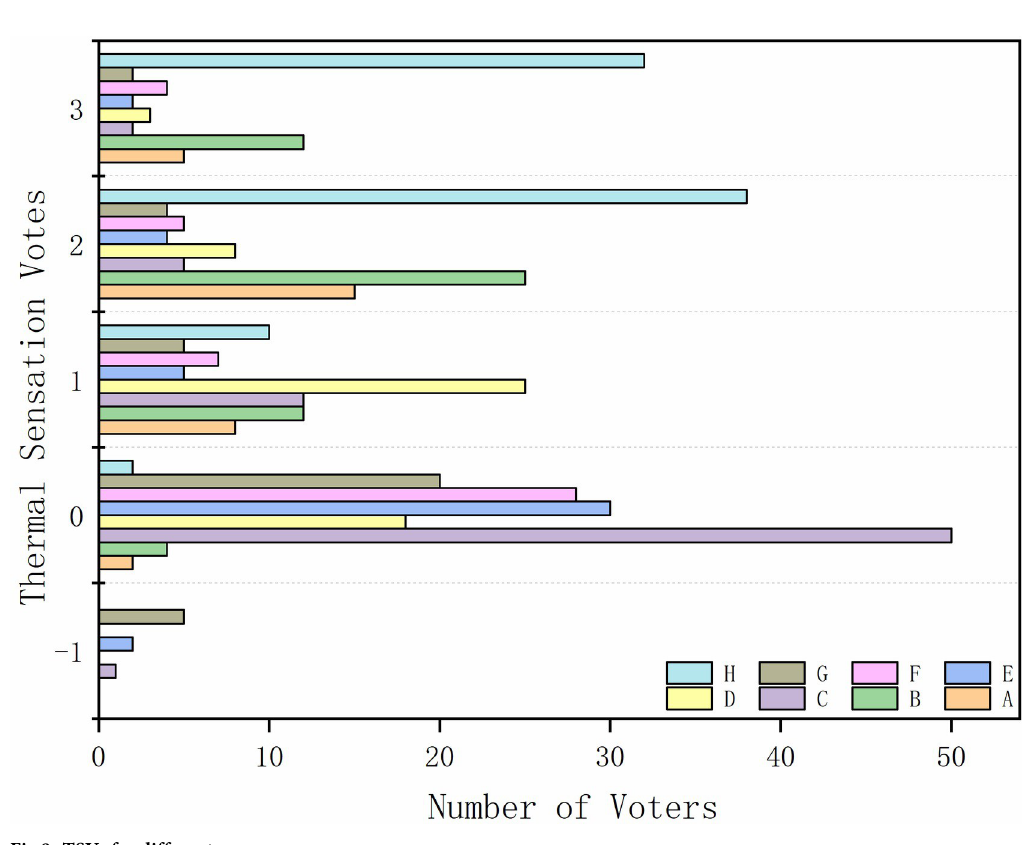
Fig 9. TSVs for different